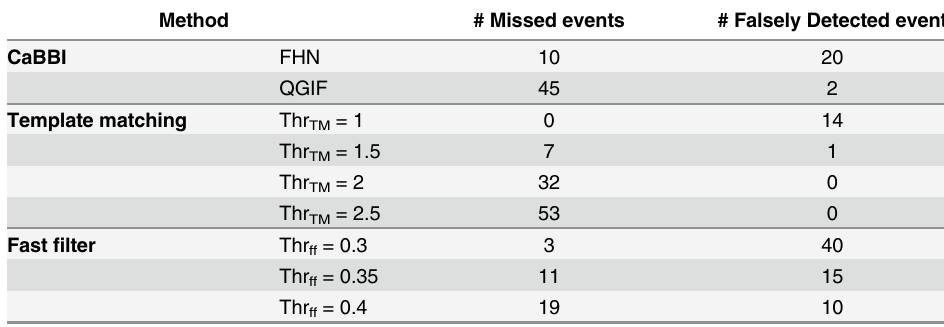
Table 5. Event detection results of three different methods (second data set). Method # Missed events # Falsely Detected event CaBBI FHN Template